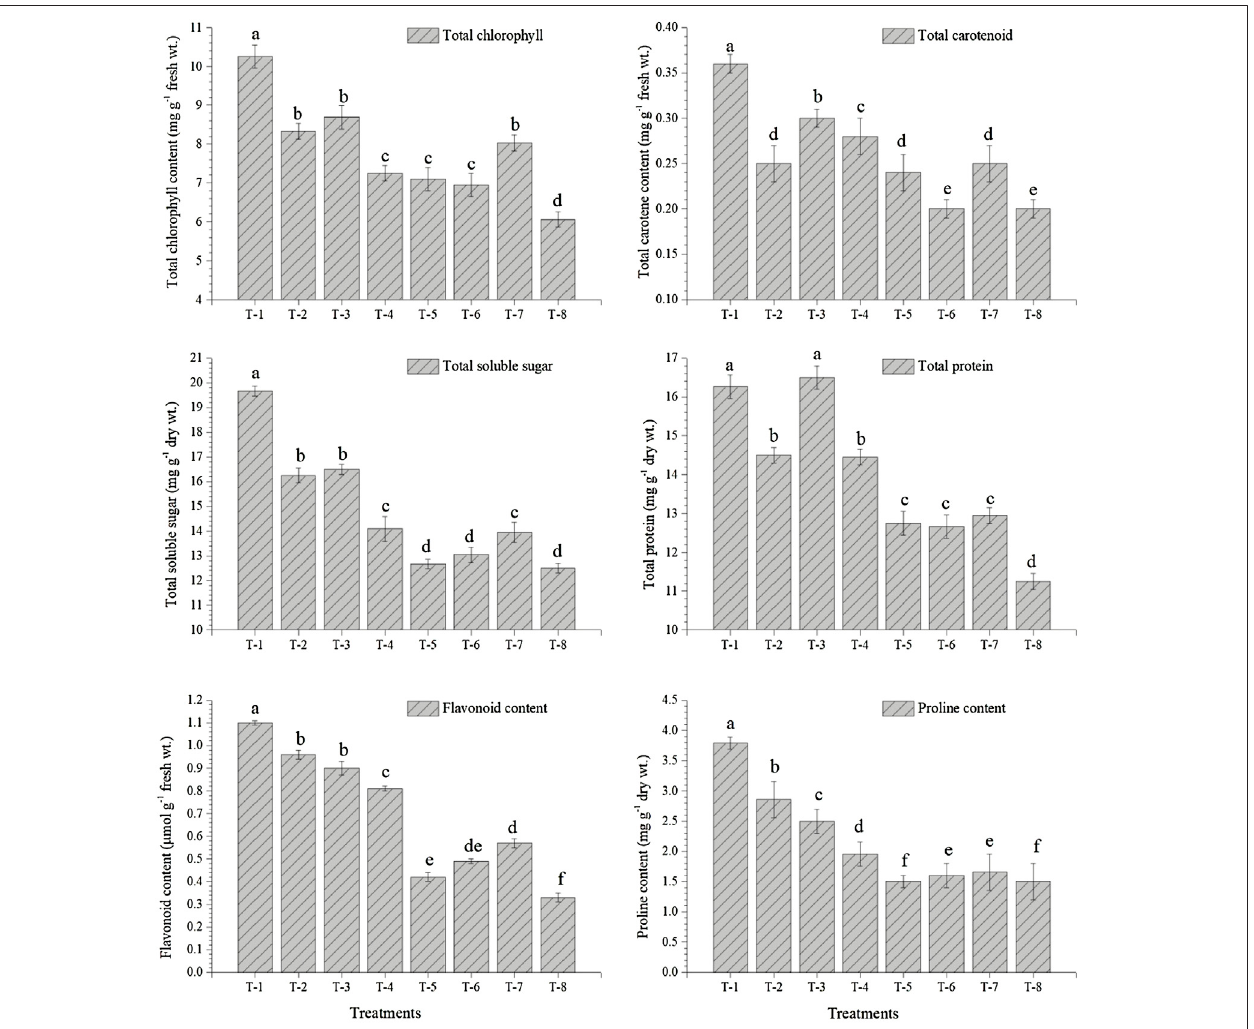
FIGURE6| EffectsofseedinoculationofSOBonaccumulationoftotalchlorophyll,totalcarotenoids,totalsolublesugar,totalprotein, fl avonoids,andprolineinthe pigeonpea leaves at 30 days of sowing. Treatments were as follows: T1 — Stenotrophomonas maltophilia DRC-18-7A, T2 — S. maltophilia DRC-18-10, T3 — S. pavanii DRC-18-7B, T4 — S. pavanii DRC-18-11, T5 — R. pusense DRC-18-25, T6 — R. pusense DSC-18-5, T7 — R. pusense DJC-18-21, and T8 — Untreated control (No inoculation). Data are mean ( n = 5) and vertical bar represents the standard deviation. Data with different letters show signi fi cant difference in column data in randomized block design test at p < 0.05 under Duncan ’ s multiple-range